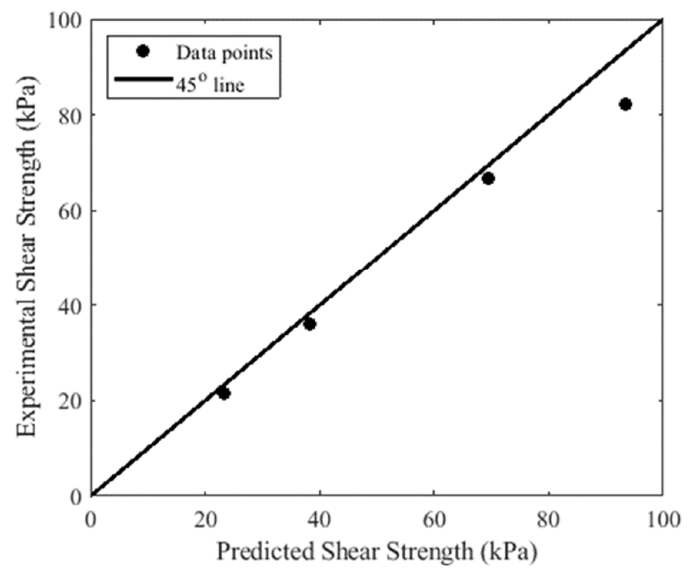
Figure 11. Comparison between measured and calculated shear strength result for VCI 70%.